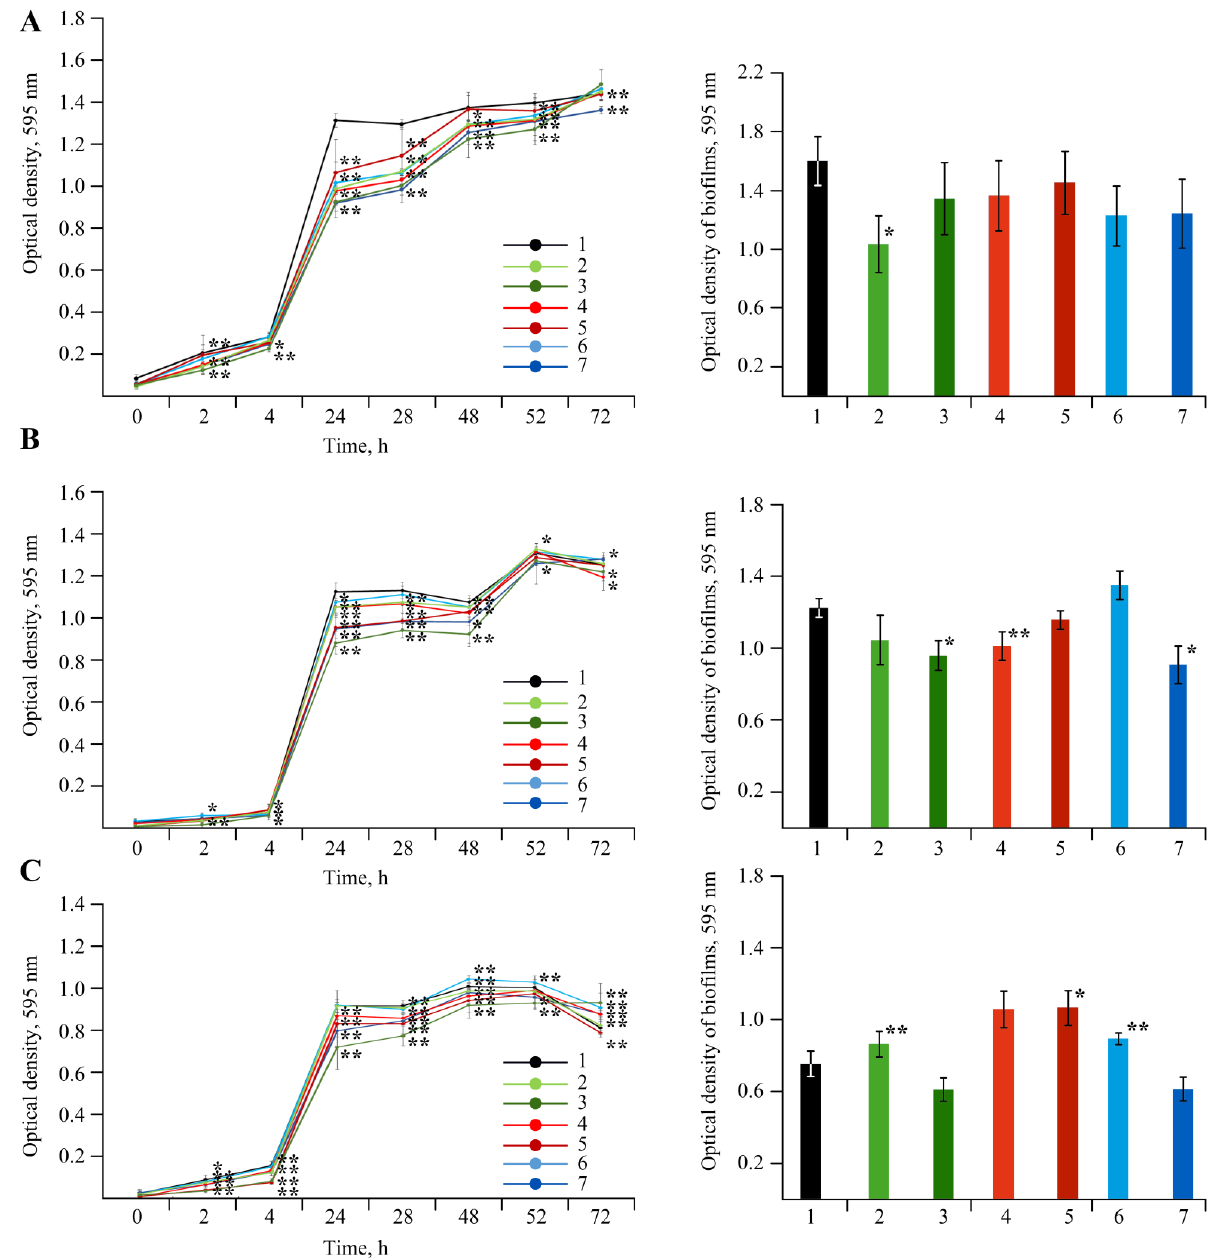
Figure 17. Effect of NC treatments with concentrations of Mn 0.000625% and 0.00625% † in volume on growth (left graph) and biofilm formation (right graph) of A. guillouiae ( A ), R. erythropolis ( B ) and P. oryzihabitans ( C ); (1)—control, (2)—AG-Mn, (3)—AG-Mn † , (4)—AGS-Mn, (5)—AGS-Mn † , (6)— κ -CG-Mn, (7)— κ -CG-Mn † ; * p ≤ 0.05 and ** p ≤ 0.01 compared to the control according to the Mann–Whitney test.